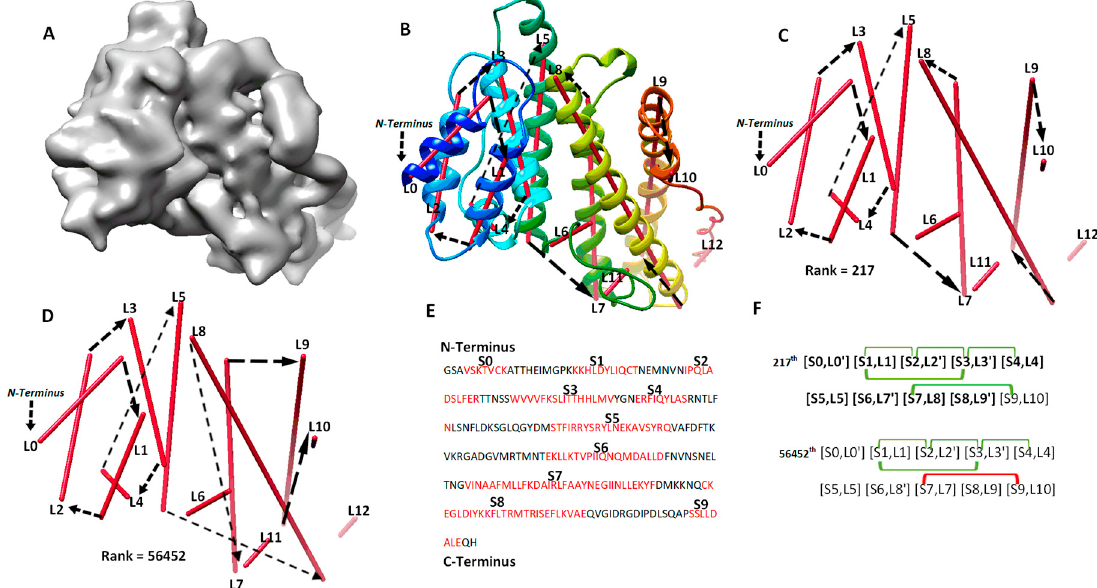
Figure 3. The maximum-match topology for case 1HG5 (PDB ID) after significant long-range contact pairs are applied. ( A ) The simulated density map of chain A of 1HG5 (PDB ID). ( B ) The 217th topology superimposed with the atomic structure (rainbow ribbon). The direction of each α -trace (red line) and the order of α -traces in the topology are indicated with black arrows. ( C ) A separate view of the 217th ranked topology, the maximum-match topology. ( D ) The 56452th ranked topology. ( E ) Secondary structures predicted using JPred [30], with helices annotated in red. ( F ) Representation of the 217th and the 56452th topology. The correctly matched pairs in the maximum-match topology are highlighted. Secondary structure contact pairs are marked in green and red for satisfaction and dissatisfaction of the distance requirement of 13 Å, respectively.